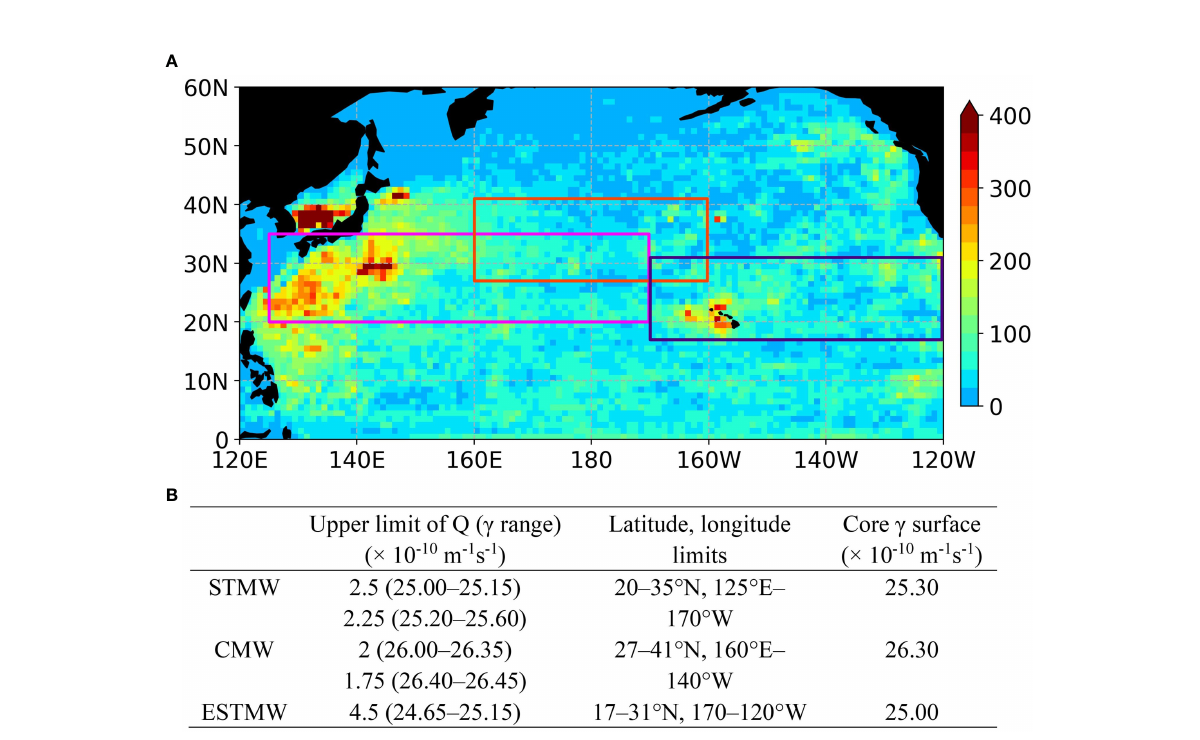
FIGURE 1 (A) Number of Argo pro fi les used in total during 2004 – 2018 for each 1° × 1° grid, averaged over g = 24.00 – 27.00. Pink, red, and purple rectangle indicates the latitude and longitude limits for STMW, CMW, and ESTMW respectively. (B) Criteria for the mode waters used for the calculation in Section 3.2.2, 3.2.3, and